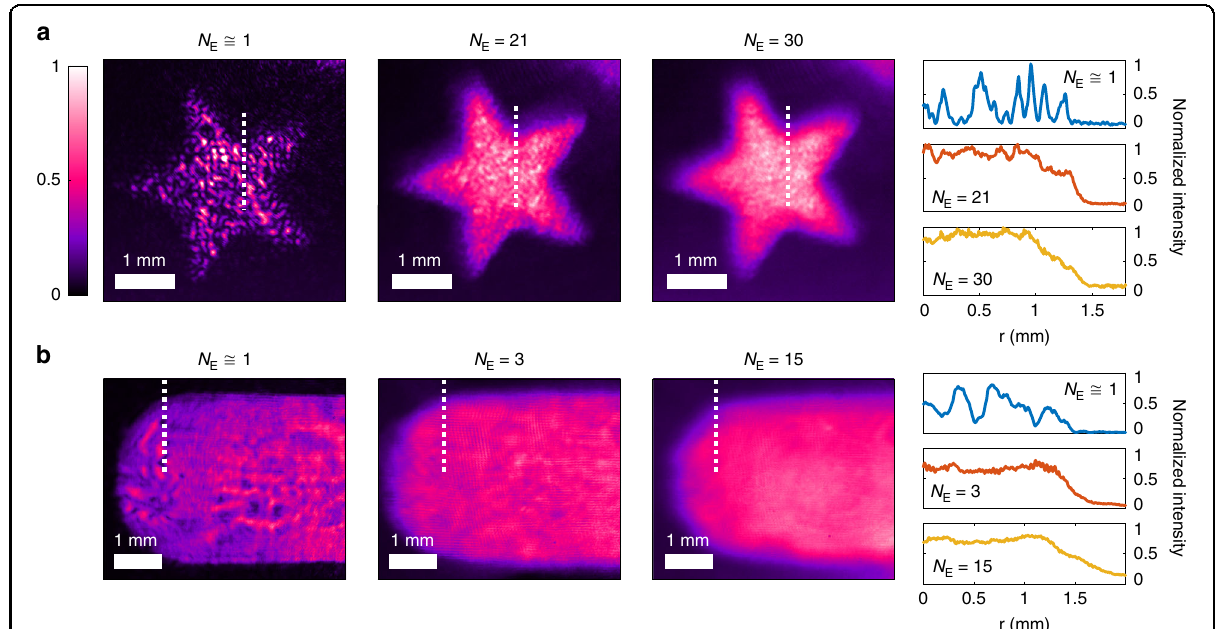
Fig. 3 Meta-holographic images under varying spatial coherence DCL illumination. The meta-holograms are based on the resonant phase modulation in ( a ), and the geometric Pancharatnam-Berry (PB) phase in ( b) . The coherent artifacts seen with high spatial coherence illumination ( fi rst column) gradually disappear, as the spatial coherence is lowered by increasing the effective number of spatial modes N E that illuminate the meta- hologram (second column). Further decrease of the spatial coherence (increase of N E ) notably blurs the image and reduces the edge sharpness (third column). The fourth column shows the 1D intensity pro fi le through a cut of the holographic images marked by white dotted line in the fi rst three